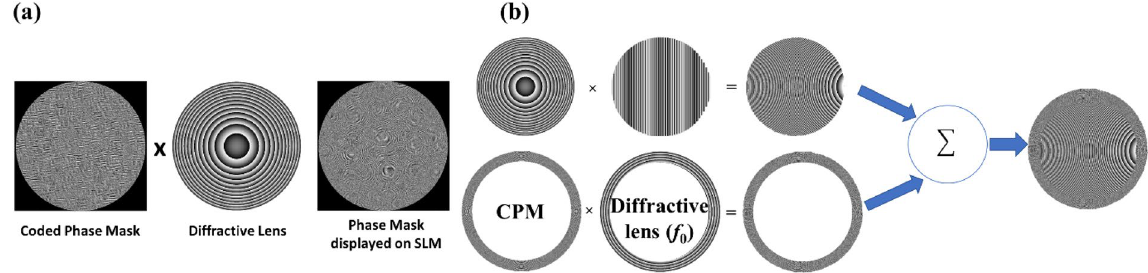
Figure 11. ( a ) Construction of full aperture CPM with diffractive lens and ( b ) of the annular CPM with